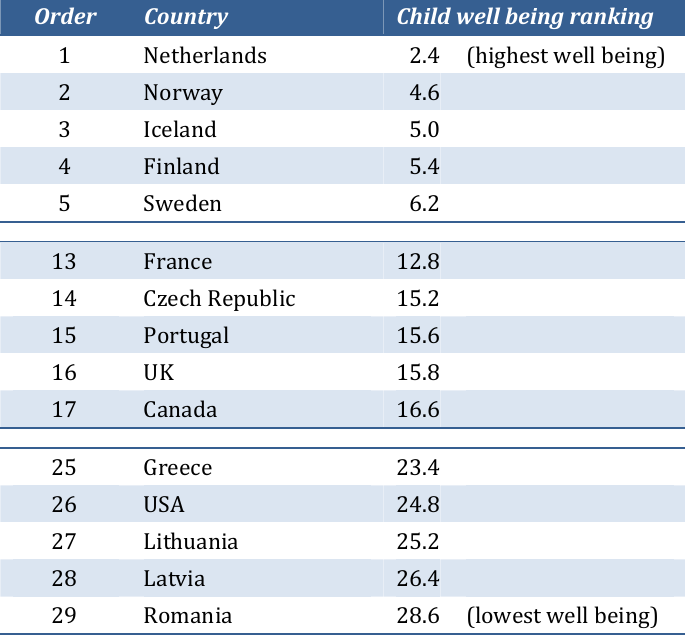
Table 6: Child well being rankings in 29 ‘rich’ countries, 2010